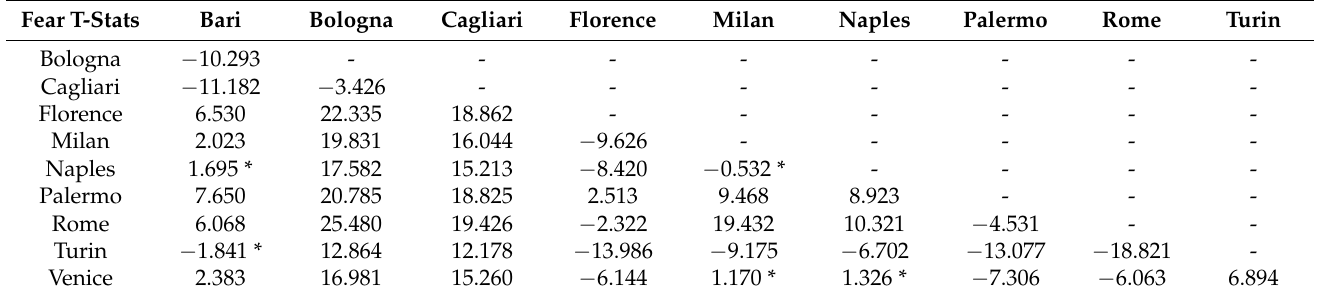
Table 4. Anger t -statistic values.